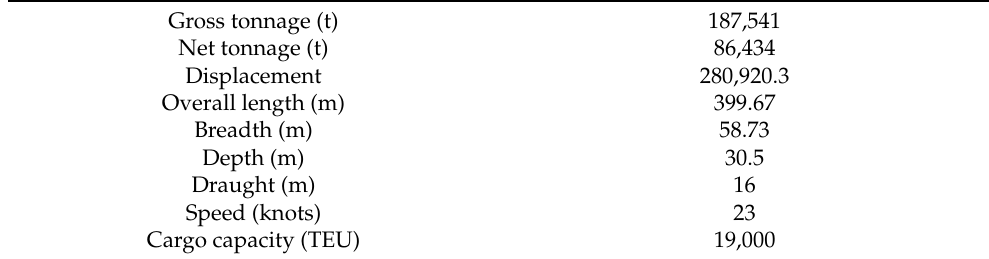
Table 2. Main ship parameters.